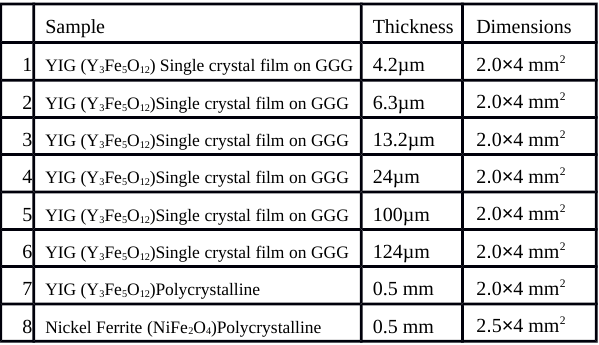
Figure 2: (a) show the simulated results of the nickel ferrite sample (NFO) along the in plane and out of plane magnetic fields. (b) show the theoretical and extracted values of the complex permeability for nickel ferrite sample. Table 1: List of FMR sampler used for measurements